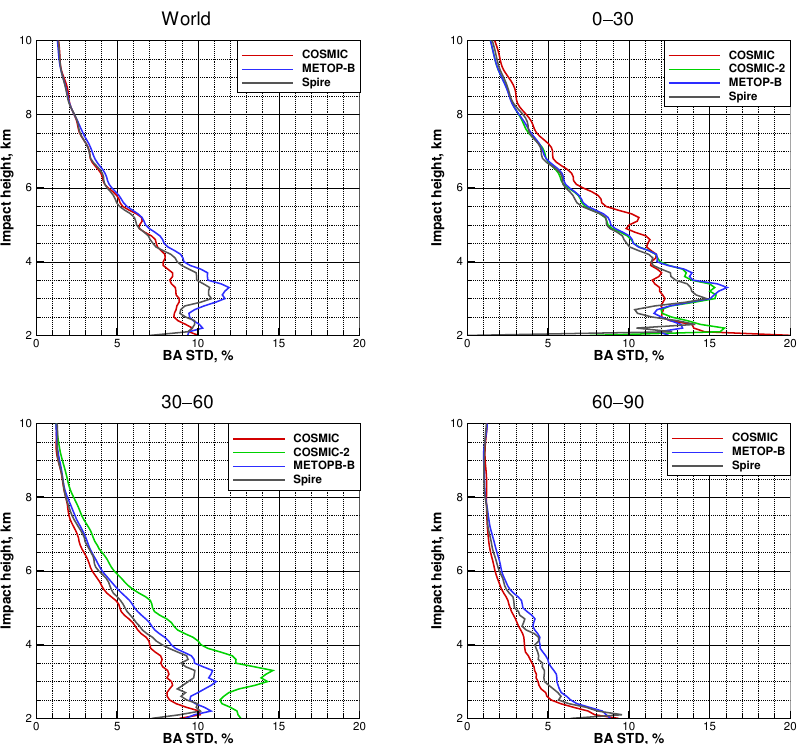
Figure 15. Similar to Figure 14. Standard deviation, dynamic normalization.